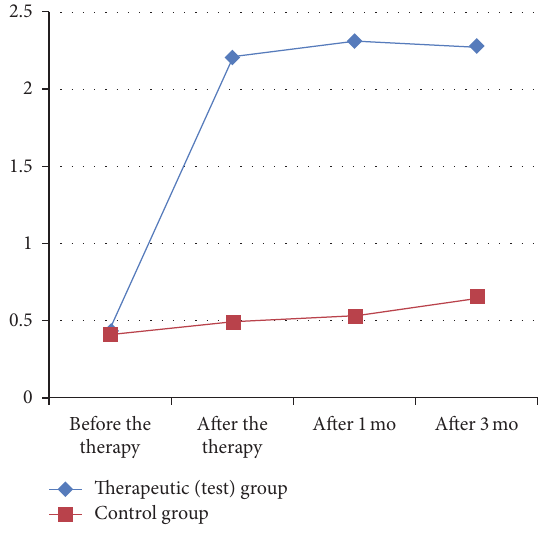
Figure4:Dynamicsofpainmeasuredbydolorimetryinthetestand control group